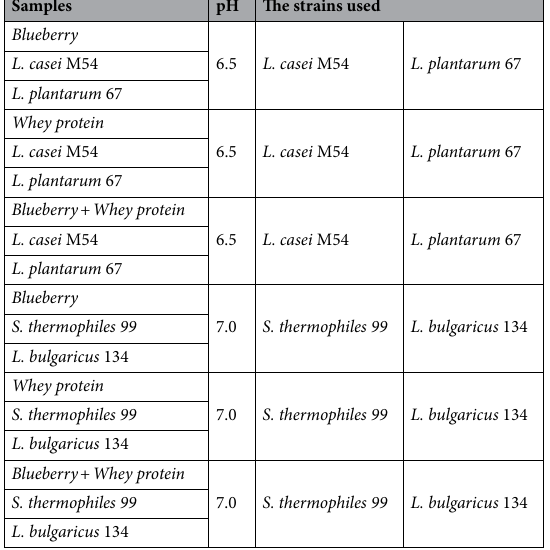
Table 1. The treatments of the